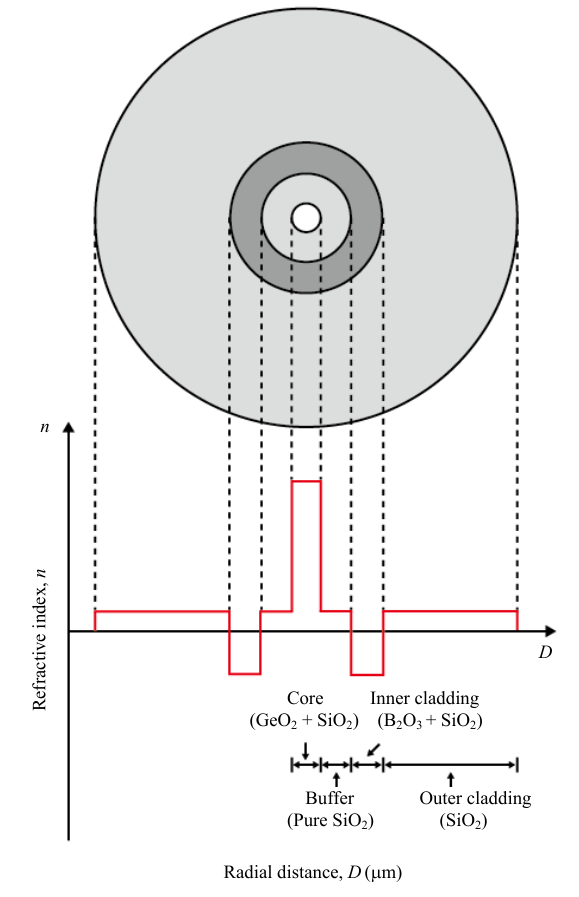
Fig. 1 Schematic diagram of the cross-section with the refractive index profile of the buffered